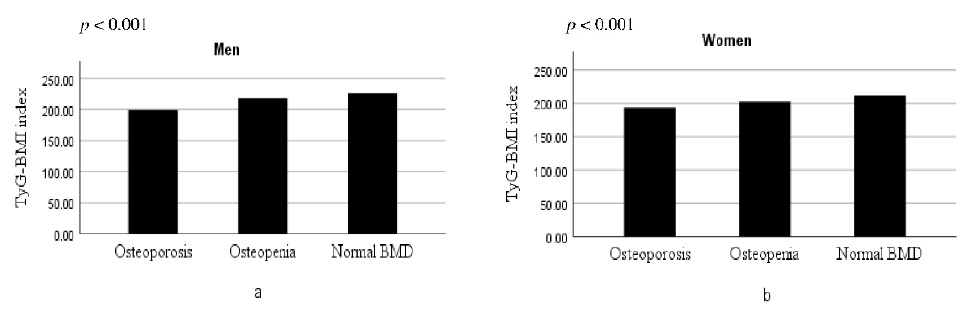
Figure 2. Distributions of the TyG-BMI according to the bone health status in men ( a ) and in women ( b ). 3.5. Multivariable Logistic Regression Analyses between Possible Predictors and Osteoporosis In the multivariable logistic regression analyses, the TyG-BMI was found to be sig- nificantly associated with osteoporosis (adjusted odds ratio (aOR) = 1.019; 95% confidence interval (CI) = 1.01–1.028) after adjusting for confounders. Age (aOR = 0.919; 95% CI = 0.892–0.947) and sex, female (aOR = 0.489; 95% CI = 0.266–0.889) were also related to oste-